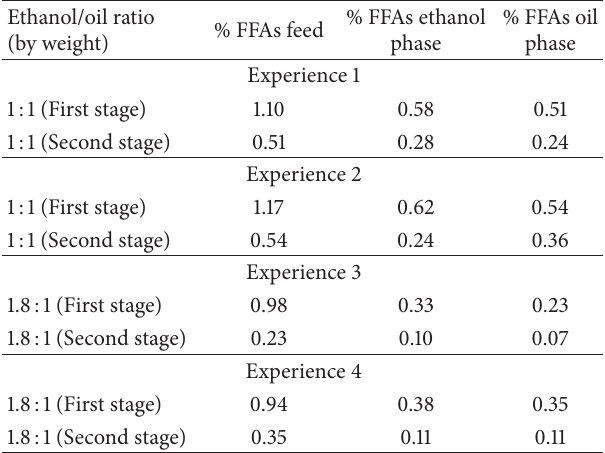
Table 1: Experimental results of extraction of FFAs from soybean oil.